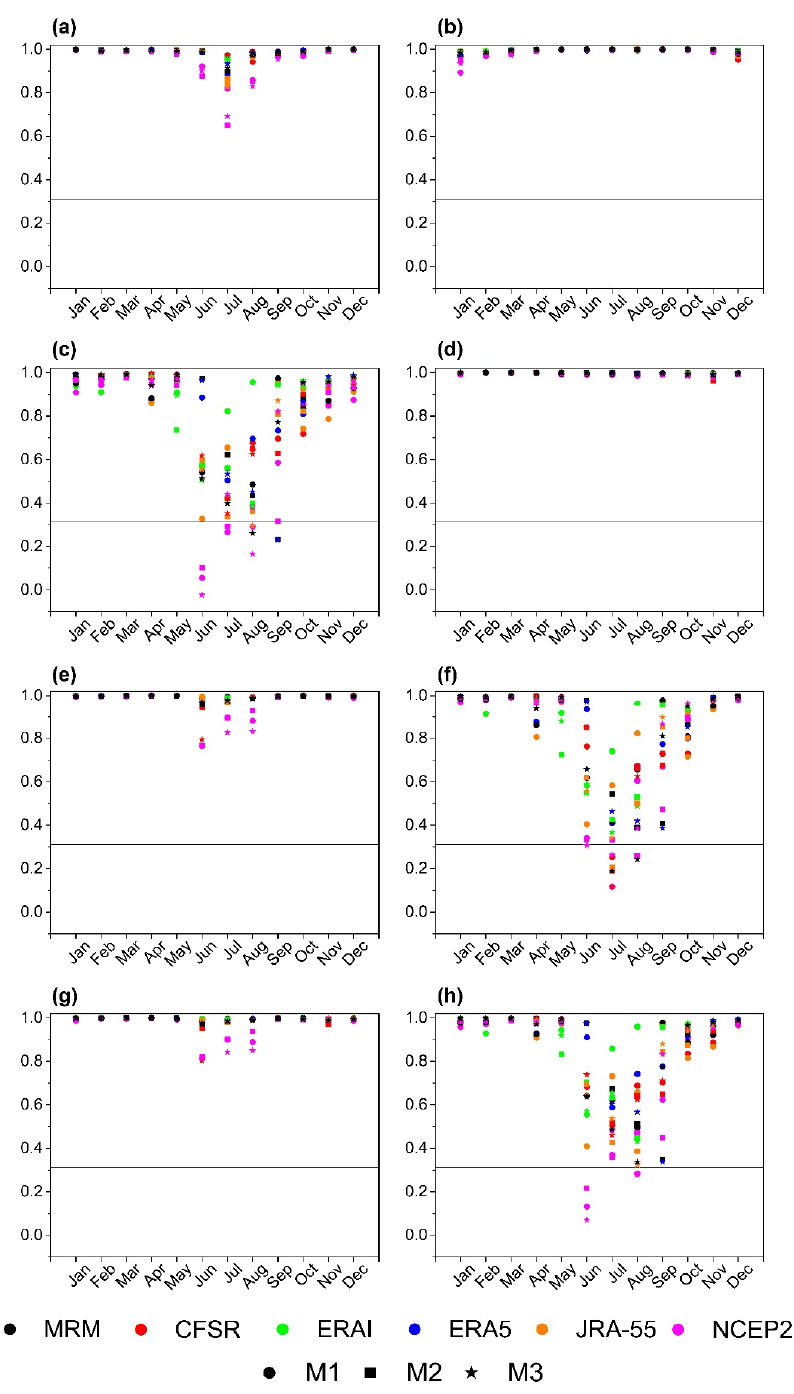
Figure 10. ( a ) Annual cycle of the correlation between the uncorrected and corrected NH HCI derived from M1 (cycle), M2 (square), and M3 (pentagram) using the MRM (black), CFSR (red), ERA-Interim (green), ERA5 (blue), JRA-55 (orange), and NCEP2 (magenta) data sets from 1979–2018. ( b – h ) Same as ( a ) but for the SH HCI, NE, SE, CE, NH HCW, SH HCW, and TOT HCW,